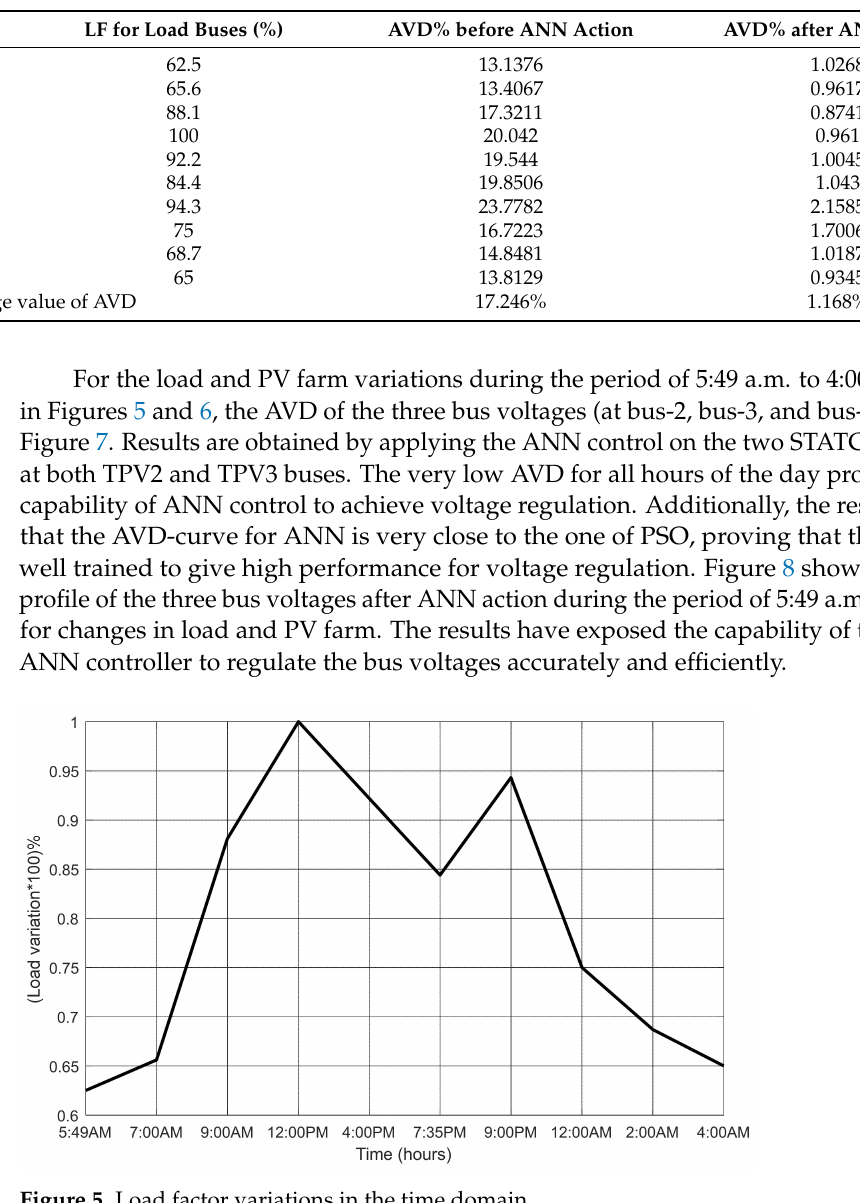
Figure 5. Load factor variations in the time